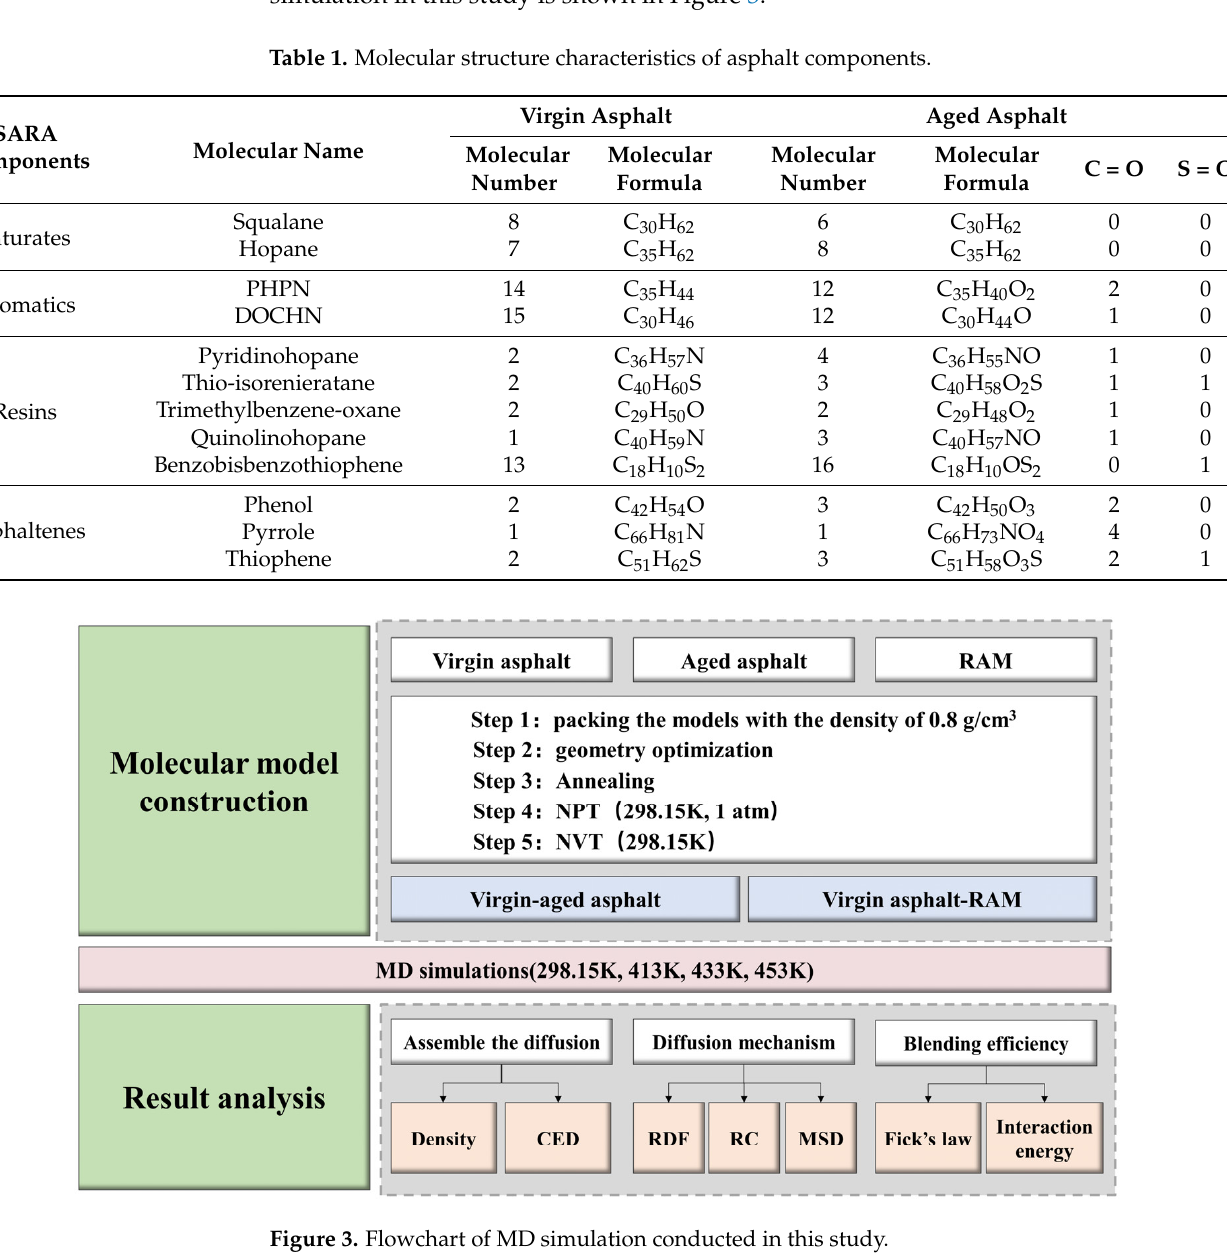
Figure 3. Flowchart of MD simulation conducted in this study. Table 1. Molecular structure characteristics of asphalt components.